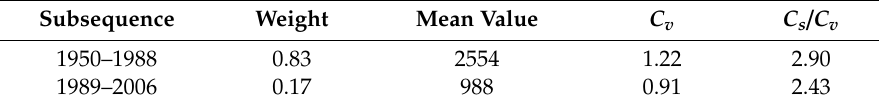
Table 4. Parameters of the simulated annealing algorithm (SAA).